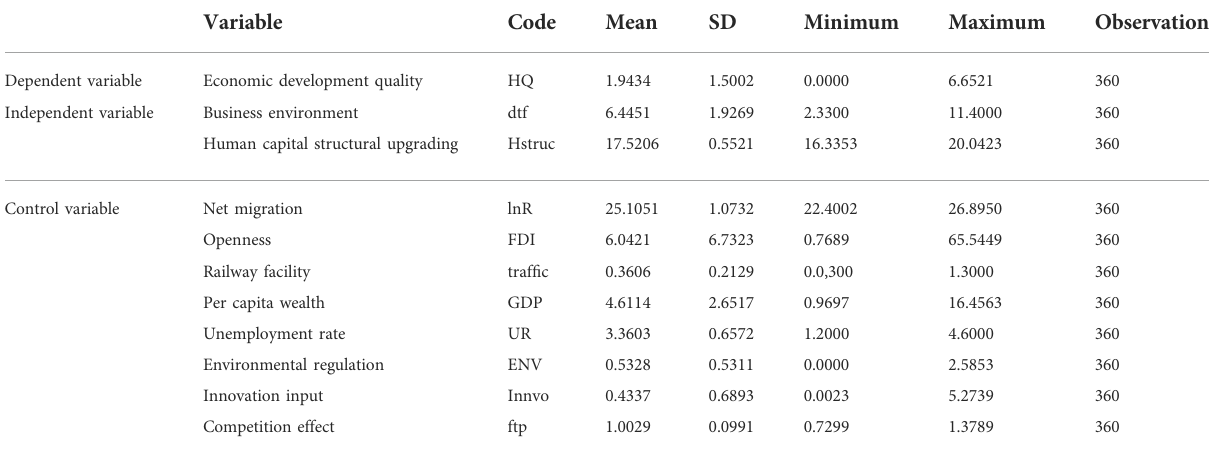
TABLE 2 Descriptive statistics of